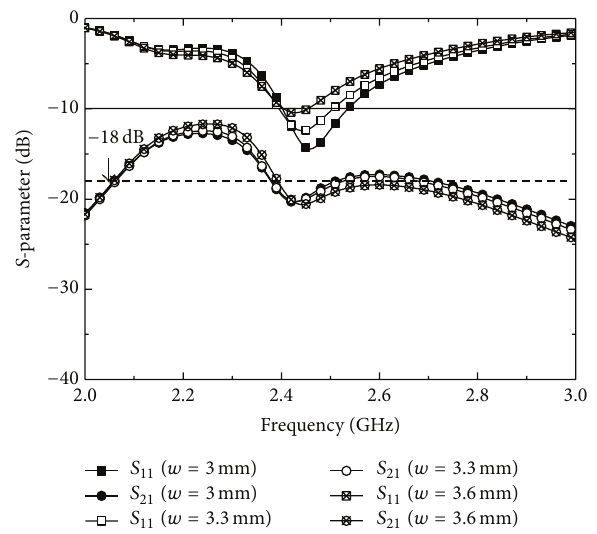
Figure 8: Simulated 𝑆 -parameter results for various values of width 𝑤 .